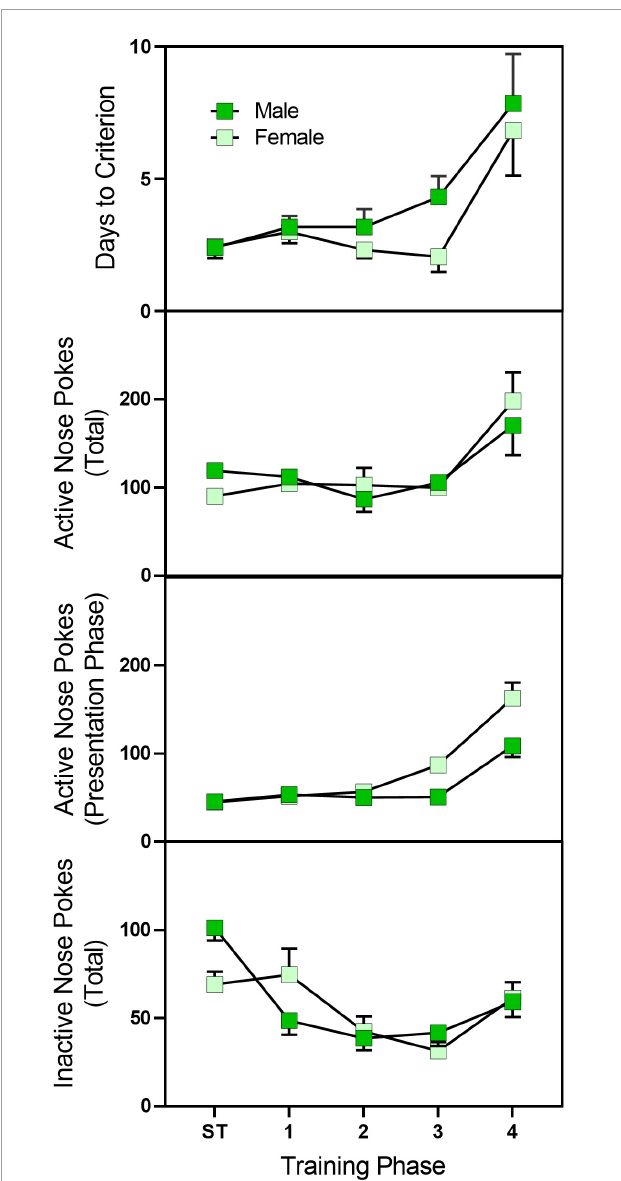
FIGURE5 Mean ( ± SEM) active nose pokes, active nose pokes during the stimulus presentation, and inactive nose pokes in late adolescent male and female rats ( n = 23–27/sex) during sucrose training and acquisition training for sucrose/fentanyl-rewarded nose pokes. Rats were pre-treated with fentanyl (10 or 100 µ g/kg) or saline from PD 4 to PD 9 and started sucrose training on PD 40. Rats first were trained to nose poke for a sucrose solution and then underwent a four-phase sucrose fade out/fentanyl fade in procedure. ST, sucrose